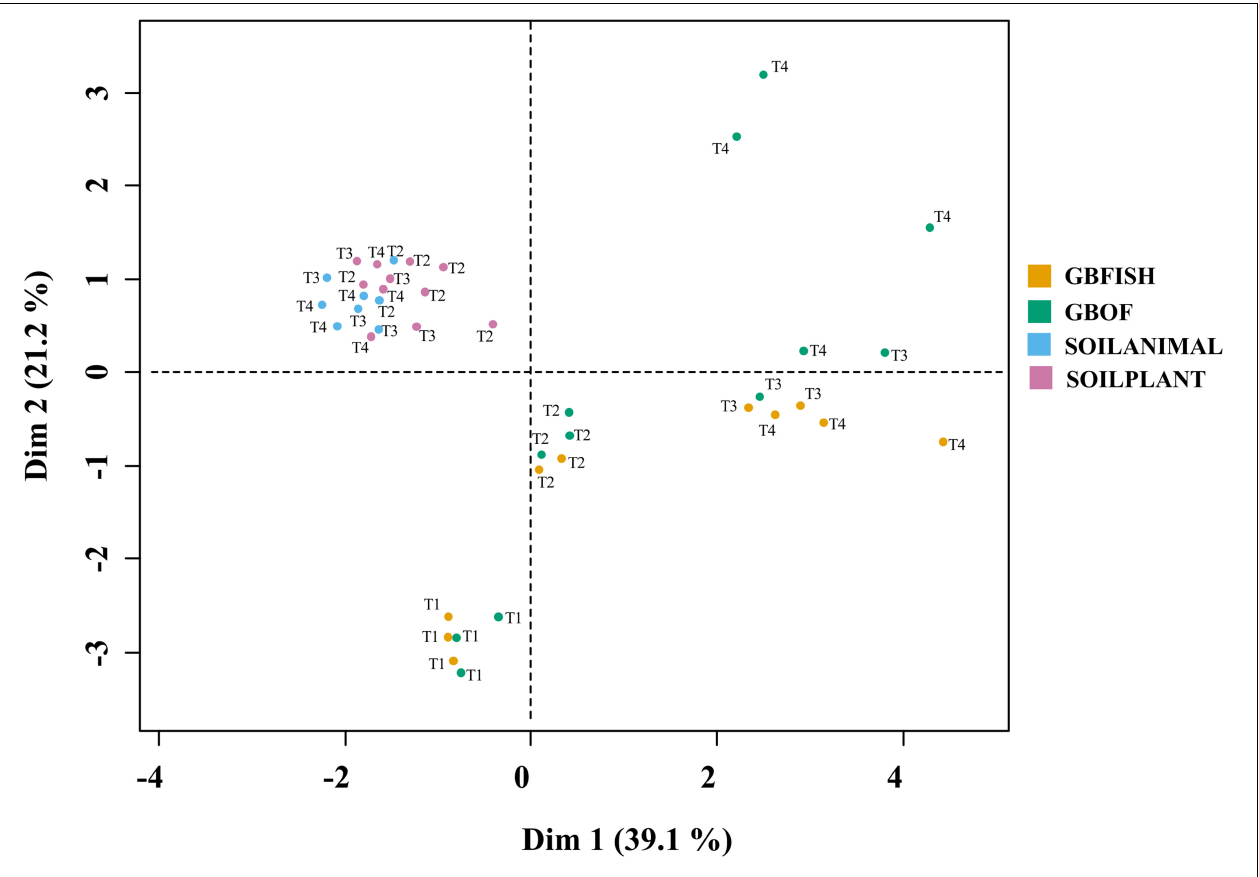
FIGURE 11 | Multiple factor analysis in which 11 chemical soil and growing medium characteristics [pH(H 2 O)]. EC (nitrate, ammonium, phosphorus, potassium, calcium, magnesium, sulfate, sodium, and chloride) and eight microbial characteristics [Gram-positive, Gram-negative bacteria, fungi 18:1, fungi 18:2, fungi 18:3, Actinomycetes, arbuscular mycorrhizal fungi (AMF), and protozoa] were used to discriminate between the different tomato cultivation systems. GBOF, organic growing medium with organic fertilizers. GBFISH, organic growing medium with fish effluent. SOILANIMAL, organic soil that was fertilizer with animal-derived material; and SOILPLANT, soil that was fertilized with plant-derived material. Samples for PLFA analyses were collected at four different time points, i.e. 55 DAS (T1), 83 DAS (T2), 221 DAS (T6) and 321 DAS